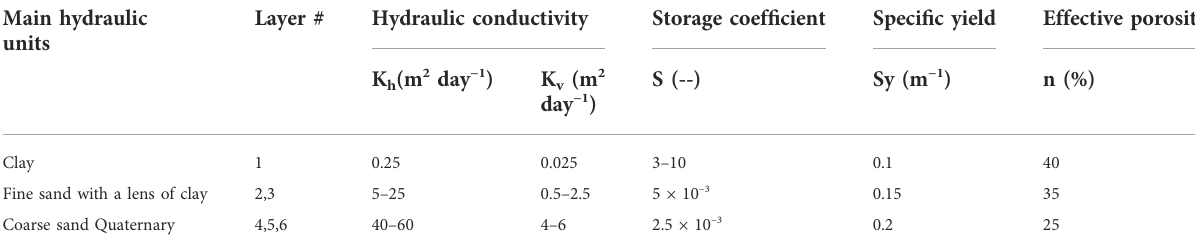
TABLE 1 Hydraulic parameters of the study area (El-Atfy, 2007; Mabrouk et al., 2018). Main hydraulic units